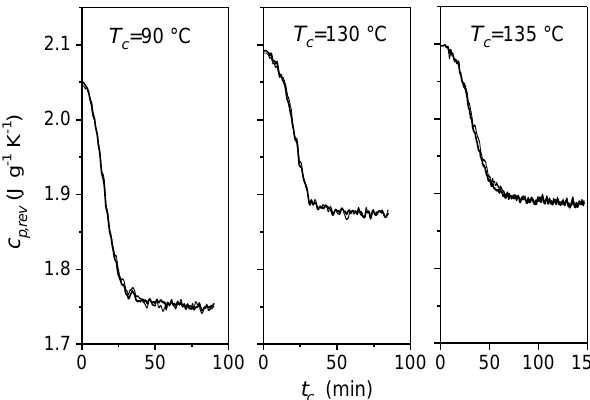
Figure 4. Crystallization time ( t c ) evolution of the reversing specific heat capacities ( c p,rev ) of poly( L - lactic acid) (PLLA) during quasi-isothermal crystallization from the melt at T c = 90 °C, 130 °C, and 135 °C, respectively ( p = 60 s: thick line, p = 120 s: thin line, A T = 0.4 K). (Reprinted (adapted) with permission from [34]. Copyright (2011) Elsevier).